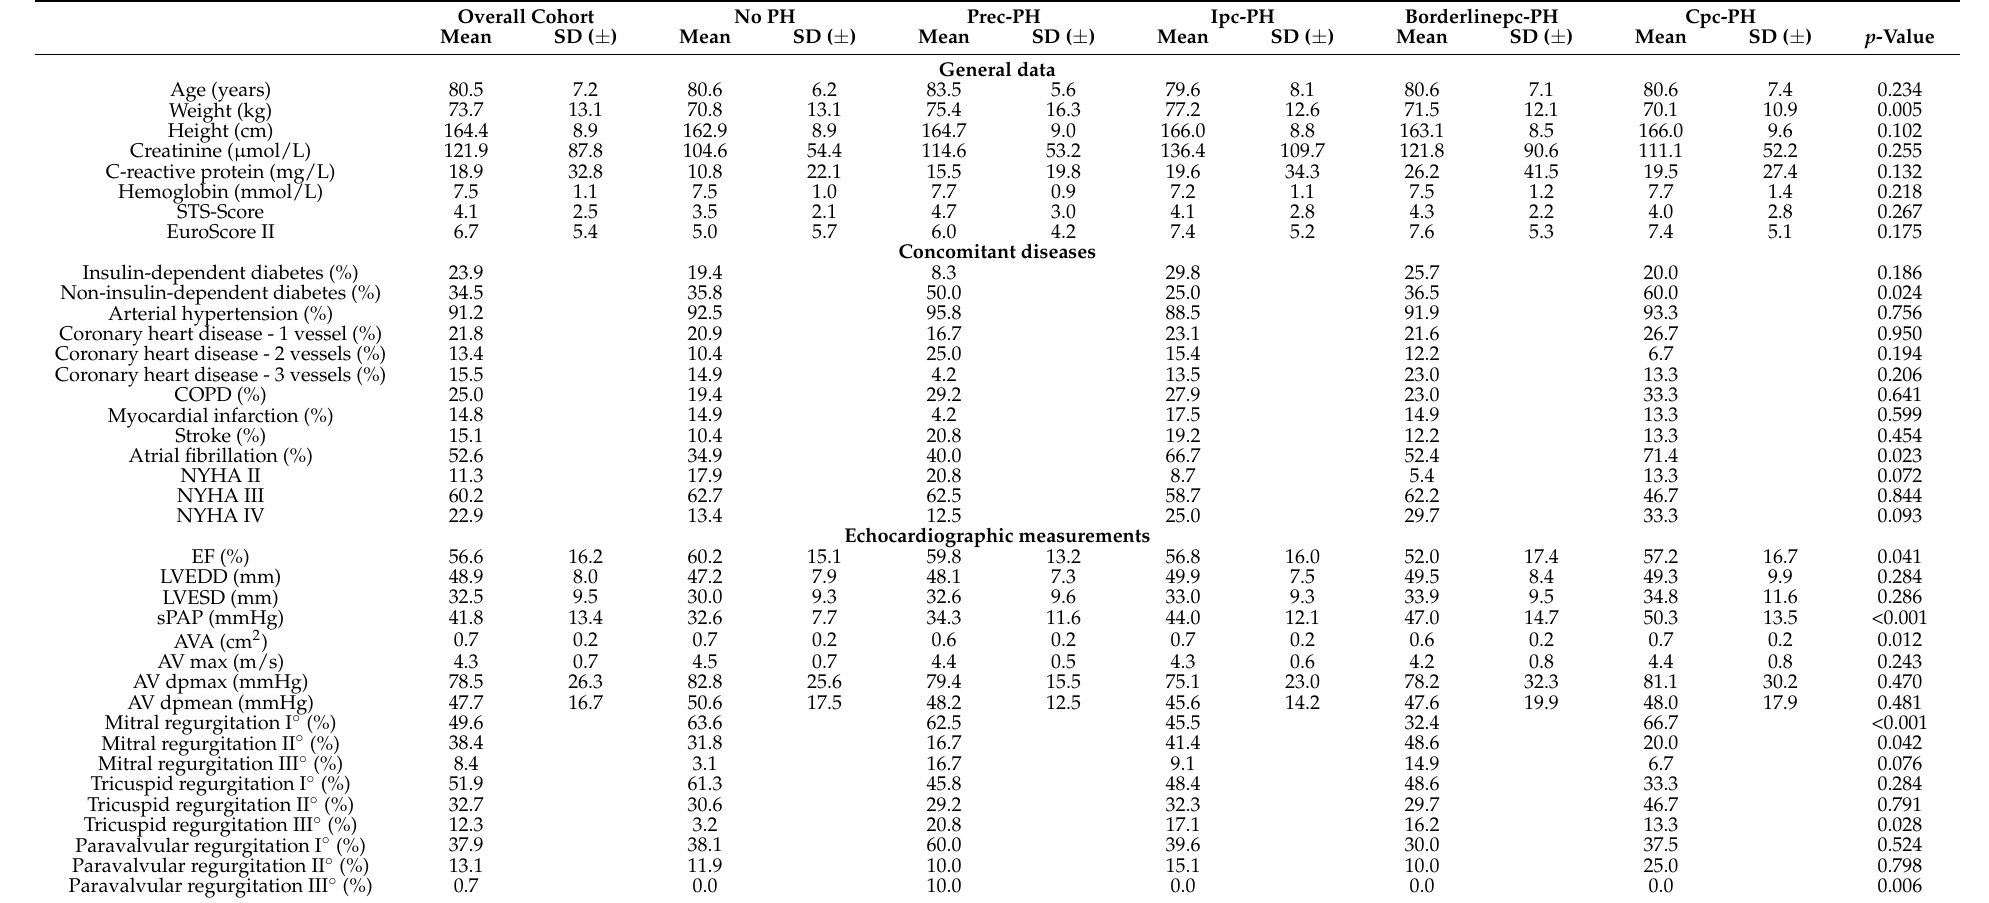
Table 1. General characteristics, echocardiographic measurements, and invasive hemodynamic profiles of study